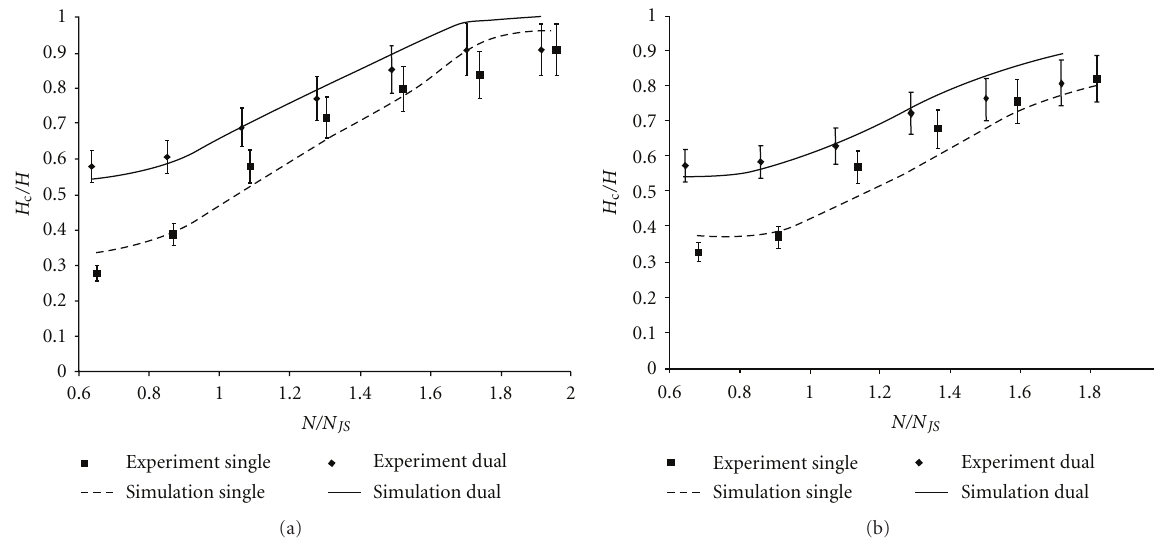
Figure 9: (a) Plot of normalized cloud height against normalized impeller speed for 10% (w/w) loading; (b) plot of normalized cloud height against normalized impeller speed for 15% (w/w)